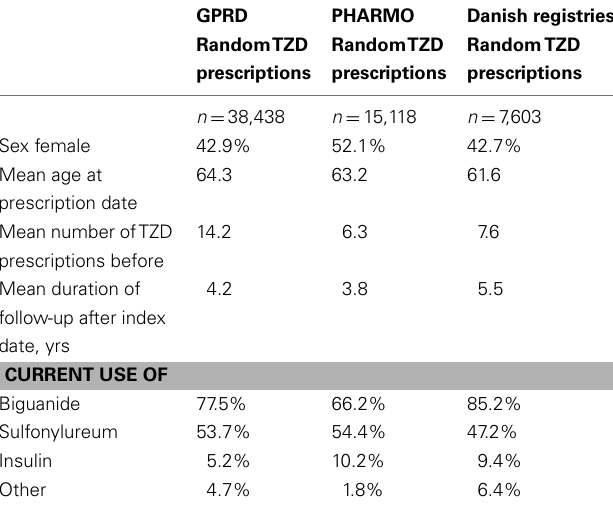
Table 3 | Characteristics of currentTZD users, based on one random prescription per